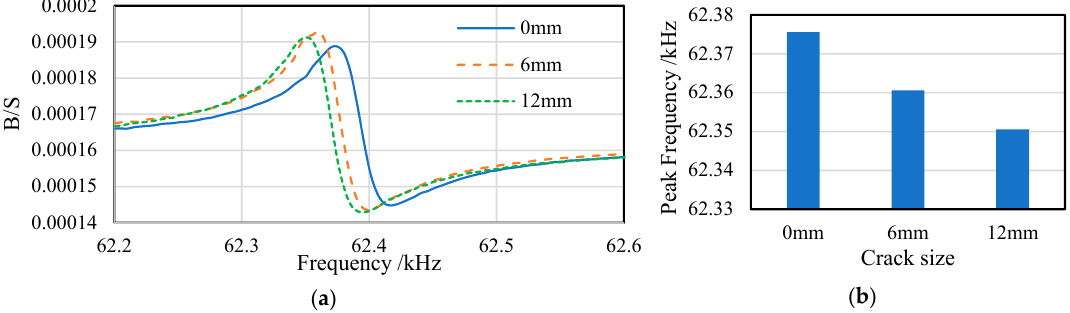
Figure 10. Experimental results ( a ) piezoelectric admittance spectrum and ( b ) peak frequency tendencies in 62.2 kHz–62.6 Hz with different crack sizes.